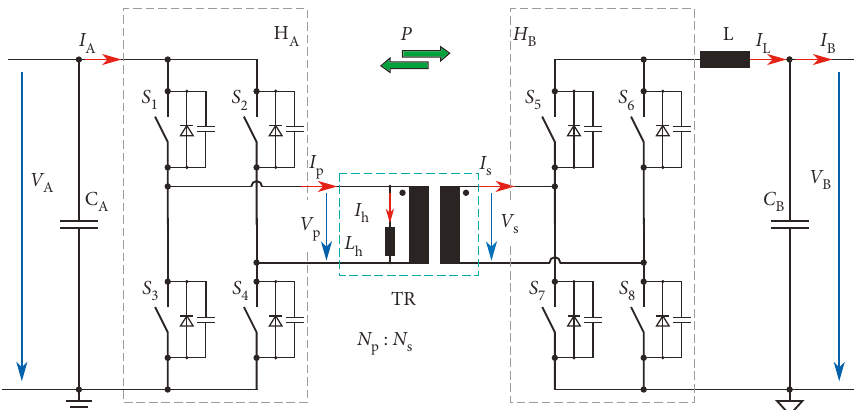
Figure 1: Phase-shift full-bridge converter topology. Two full-bridges H Transformer TR partially compensates high voltage difference between V